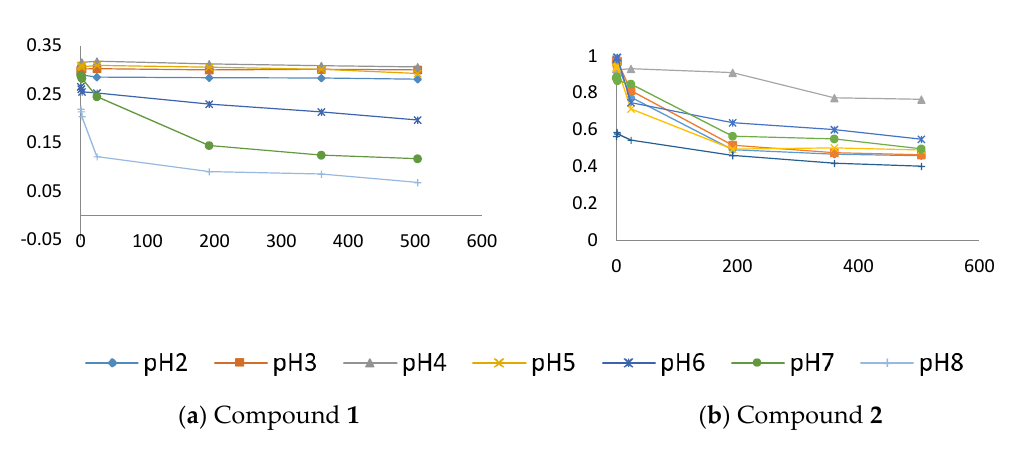
Figure 5. Fluorescence of HaCaT cell line exposed to 1,2-DHX ( 1 ; 12.5, 25, 50, 100, and 200 µM) as determined by the DCFH-DA assay. Data are presented as mean ± SD ( n = 3) relative to solvent control = 100 ± 1.7 ( n = 3). Data were analyzed using one-way ANOVA with a Dunnett post hoc test. 3. Materials and Methods 3.1. Materials All reagents and solvents were purchased from TCI (Tokyo Chemical Industry Co. Ltd., Chuo- ku, Tokyo, Japan), Acros (Geel, Belgium), Sigma-Aldrich (Sigma-Aldrich Co. Ltd., Gillingham, UK), or Alfa Aesar (Thermo Fisher GmbH, Kandel, Germany) and had no further purification process. Solvents were evaporated using a rotary evaporator under reduced pressure, Buchi Waterchath B- 480 (BÜCHI Labortechnik AG, Switzerland). The reaction was monitored by TLC carried out on precoated plates with 0.2 mm thickness using Merck (Darmstadt, Germany) silica gel 60 (GF254) with